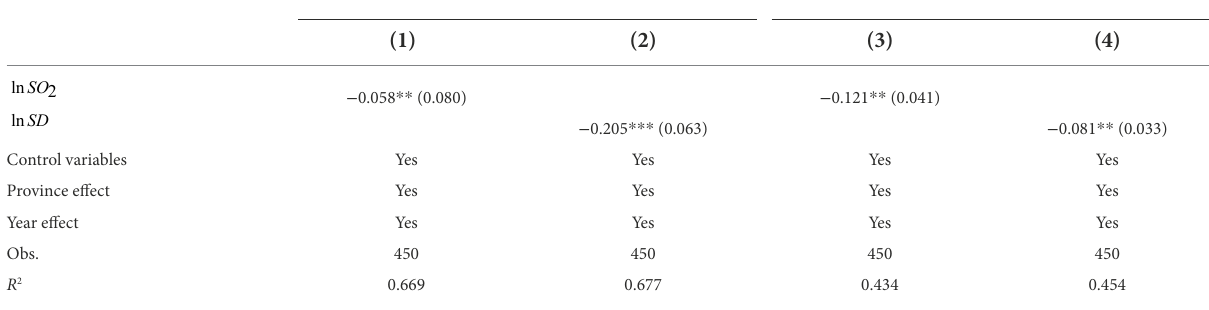
TABLE 3 Robustness tests.